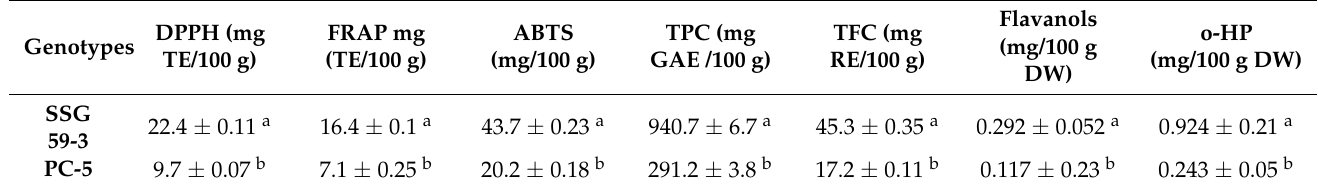
Table 2. Antioxidant activity and polyphenolic composition of sorghum